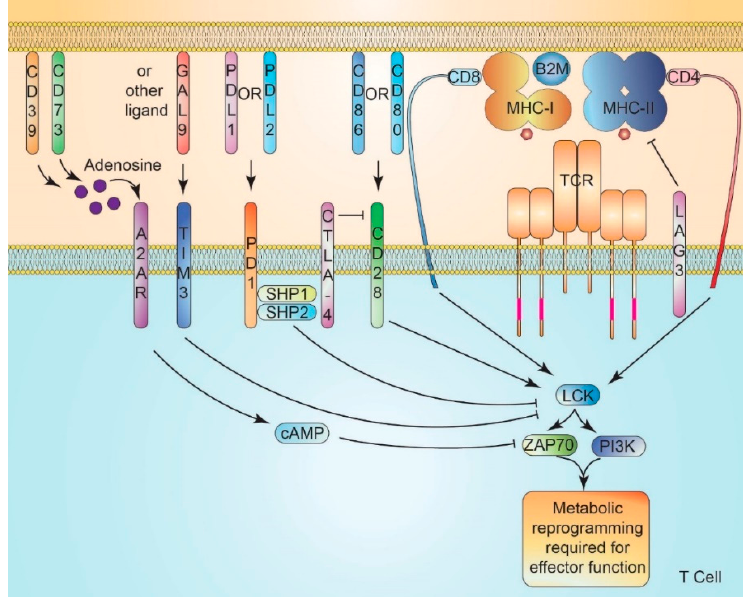
Figure 2. Immune checkpoint signaling abrogation of T cell receptor signaling and metabolic adaptation. Competition between CTLA-4 (cytotoxic T-lymphocyte-associated protein 4) and CD28 for CD80 and CD86 results in loss of CD28 costimulatory signals. Binding of PD-L1 (programmed death ligand 1) or PD-L2 (programmed death ligand 2) to PD1 (programmed death-1) recruits SHP1 and SHP2 (Src homology region 2 (SH2)-containing protein tyrosine phosphatase 1/2) to suppress TCR activation of Lck (LCK Proto-Oncogene, Src Family Tyrosine Kinase). Binding of GAL9 (galectin 9)(or other ligands) to TIM-3 (T cell immunoglobulin and mucin domain-containing protein 3) results in the detachment of BAT3 (HLA-B-associated transcript 3) and loss of Lck localization to the immune synapse. LAG3 (Lymphocyte Activating 3) antagonizes antigen presenting cell function via suppressive interaction with MHC-II (major histocompatibility complex class II), with additional yet poorly understood T cell-intrinsic signaling likely. The production of adenosine from extracellular ATP by CD73 and CD39 promotes the activation of A2AR (adenosine A2A receptor), which suppresses T cell activation via cAMP (cyclic AMP) production. 10. Metabolically-Mediated TME Immunomodulation 10.1. Lactate High concentrations of lactate, an end product of glycolysis, are critical regulators of the TME [170]. Tumor masses are major contributors to high lactate concentrations, producing up to 40 times